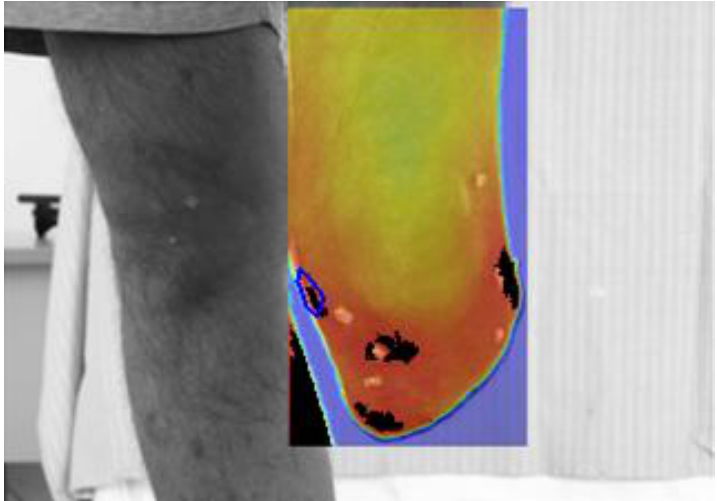
Figure 6. The image processing and the identification of the four ROI-hot spots at the human-prosthesis interface (on the right side, i.e ., the stump of the left